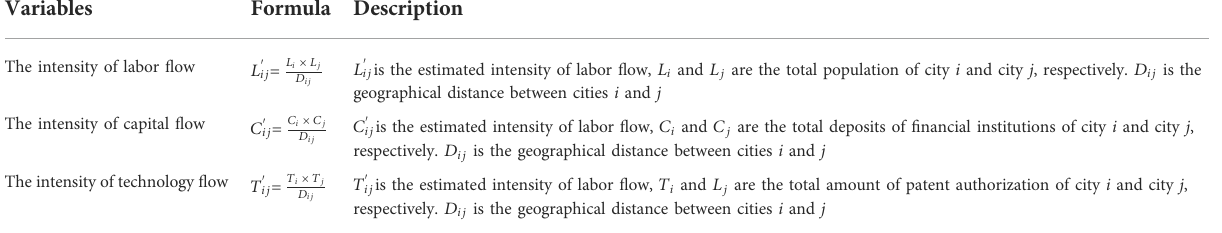
TABLE 2 Formulas for estimating the intensity of production factors fl